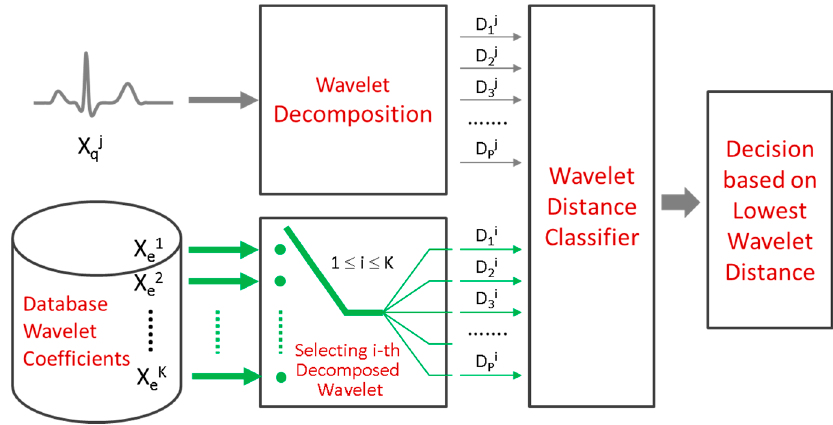
Figure 10. 1-to- (cid:1837) template matching using wavelet distance measure. Figure 10. 1-to- K template matching using wavelet distance